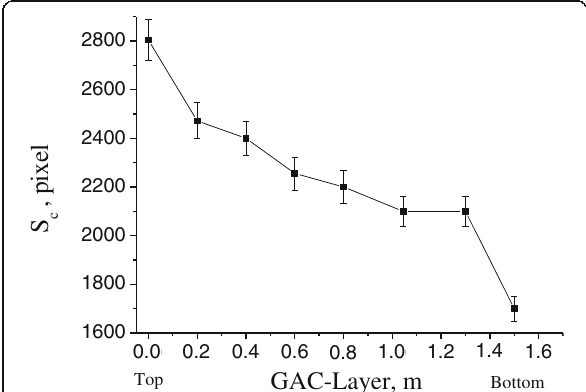
Fig. 11 GAC exhaustion profile in the rum filter based on the spatial concentration analysis of X-ray radiography digital image